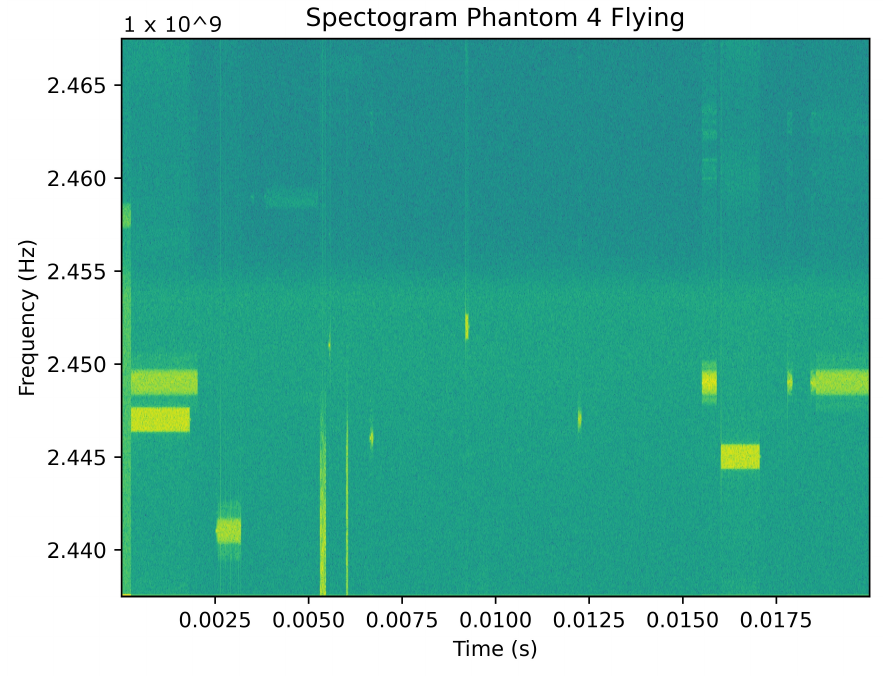
Figure 8. Spectrogram: Phantom 4